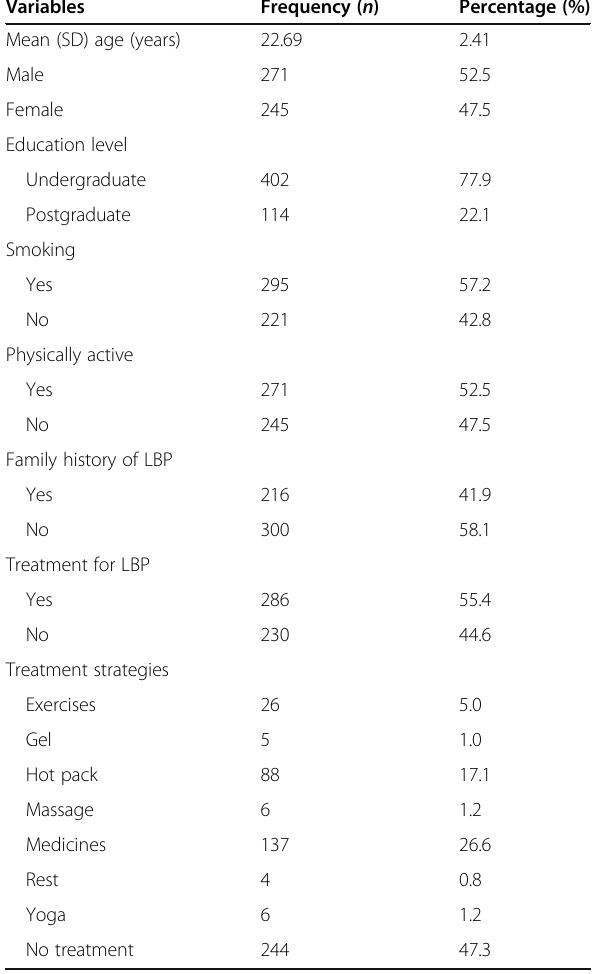
Table 2 Demographic characteristics of the